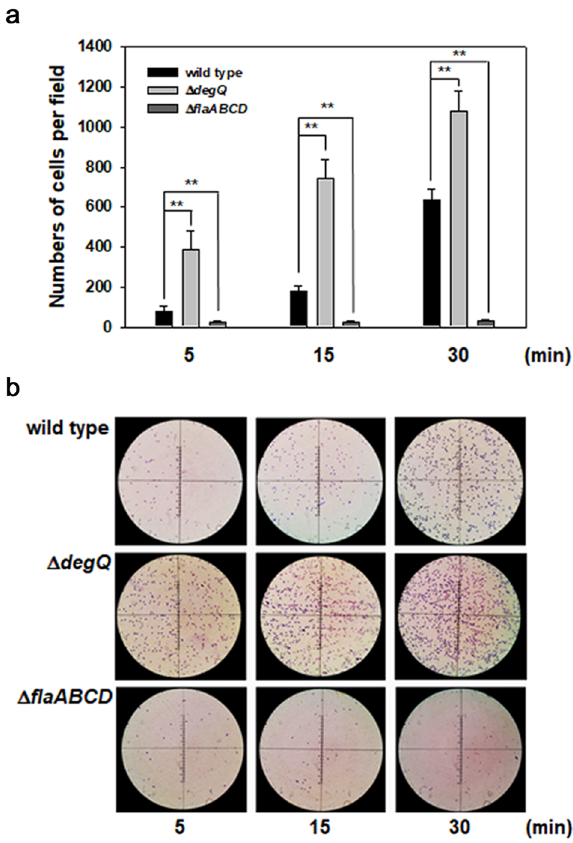
Fig. 3 Effect of degQ mutation on bacterial adherence on slide glasses. Slide glasses were submerged in fl asks containing the AB- fumarate broth inoculated by wild-type or Δ degQ strains of V. vulni fi cus at an OD 595 of 0.2. After 5, 15, and 30 min, the bacterial cells attached on the slide glasses were stained with crystal violet and were counted under the light microscope. To differentiate the bacterial adherence via swimming motility or random contacts to slide glasses, a non-motile mutant of V. vulni fi cus , Δ fl aABCD , was included as a negative control 12 . Average numbers of adherent cells per a light-microscopic fi eld (at least 18 fi elds observed) were presented with the error bars representing standard deviations ( a ). The P- values for comparison with wild type are indicated (Student ’ s t -test; ** P < 0.005). Representative pictures of the slides adhered by three strains for 5, 15, and 30 min were presented ( b